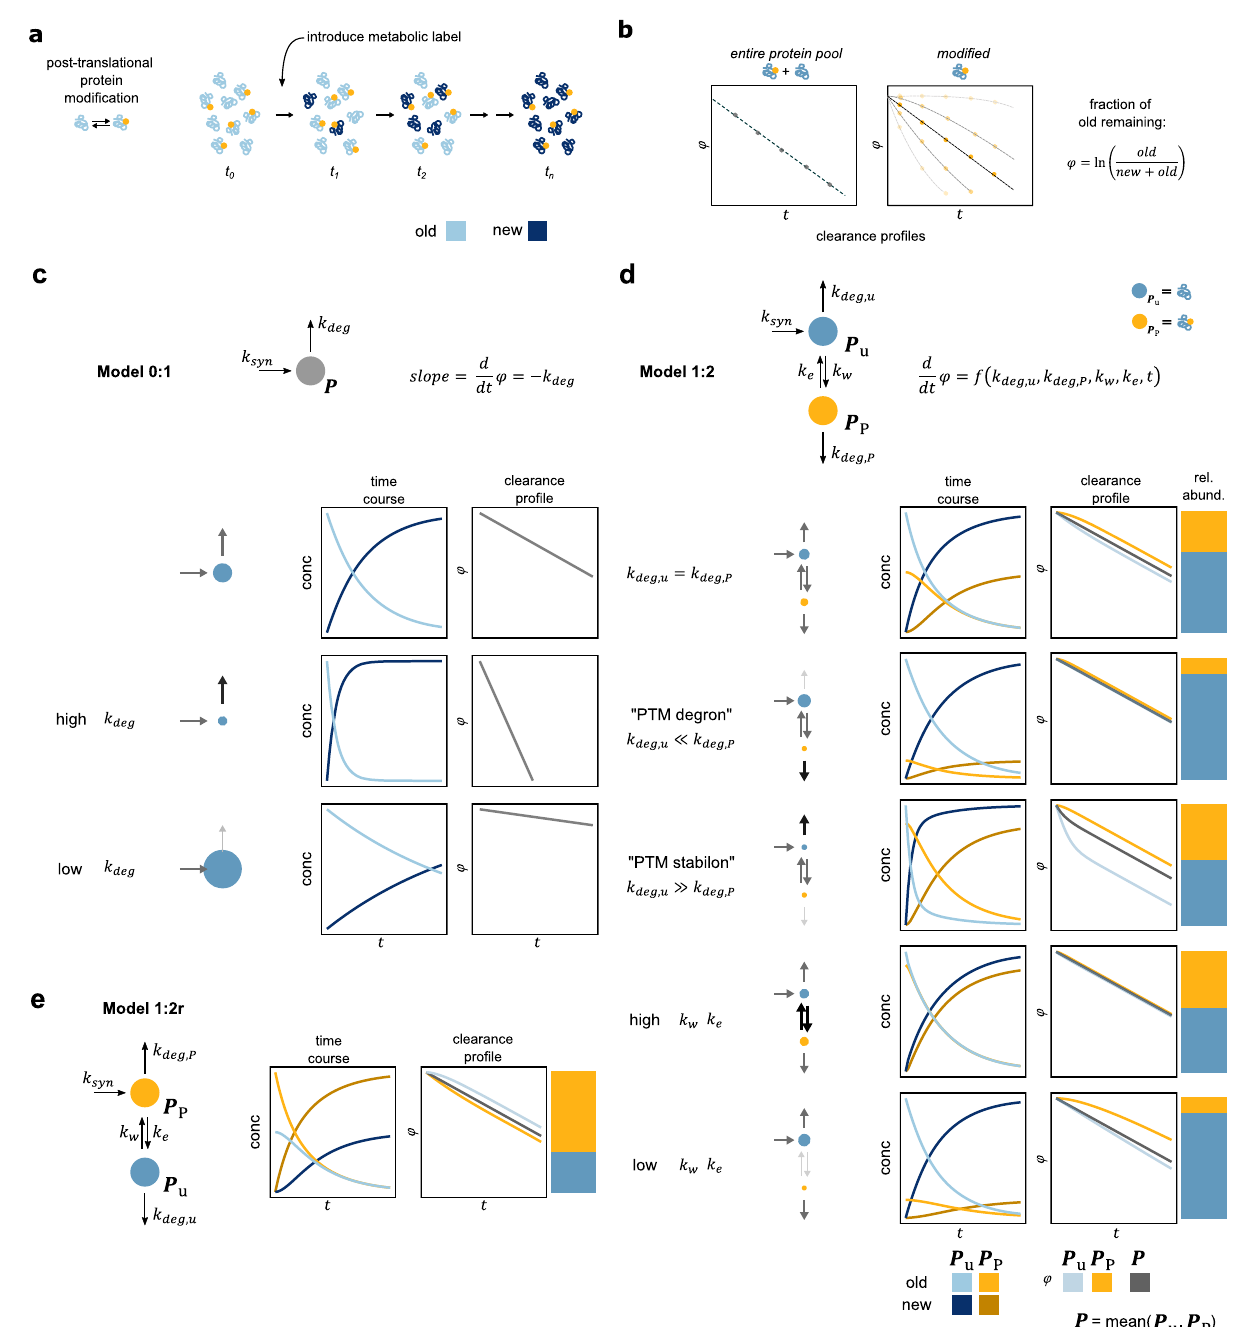
Fig. 1 | Quantitativemodeling ofmulti-speciesmetabolic labeling experiments identi fi eslimitsandpossibilitiesoftheapproach.a Inasteady-statesystemwith interconverting species, such as proteins with or without a PTM, an introduced metabolic label equilibrates into both unmodi fi ed and modi fi ed protein species through writing and erasing of the PTM (yellow circle). b Previous pulse-labeling experiments have shown that clearance of modi fi ed peptides can differ sub- stantially from the rest of the protein. Shown are archetypal clearance pro fi les (logarithm of fraction of old protein remaining, φ , over time, t ) for the entire protein pool (gray) and the modi fi ed species (yellow). c In the simplest, single- species model for protein turnover, the slope of the clearance pro fi le is directly de fi ned by the protein degradation rate constant, k deg . Models are named “ Model x:y ” (e.g.,Model0:1)indicatingthenumberofmodi fi edspecies(x),andthenumber of species altogether (y). In the small cartoons, the size and opacity of the arrows